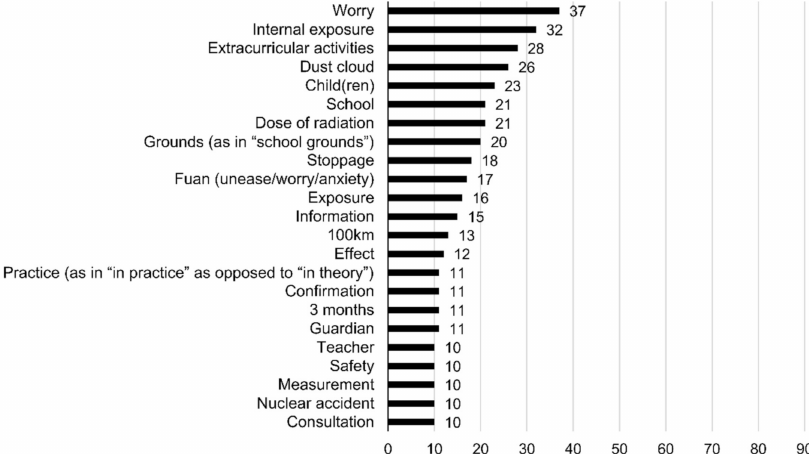
Figure 2. The nouns that students wrote on the pre-class worksheet with regard to how they would respond to the example scenario and the number of students who wrote them.